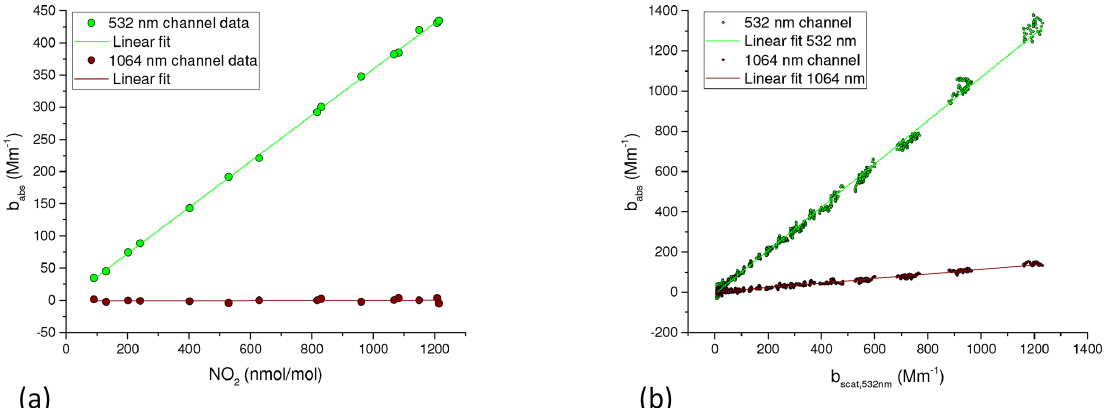
Figure 11. Instrument response to different amount fractions of NO 2 (a) and nigrosin particles (b) .